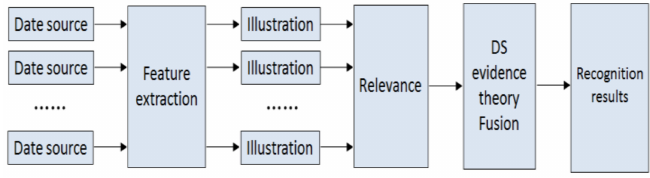
Figure 2. Decision-layer